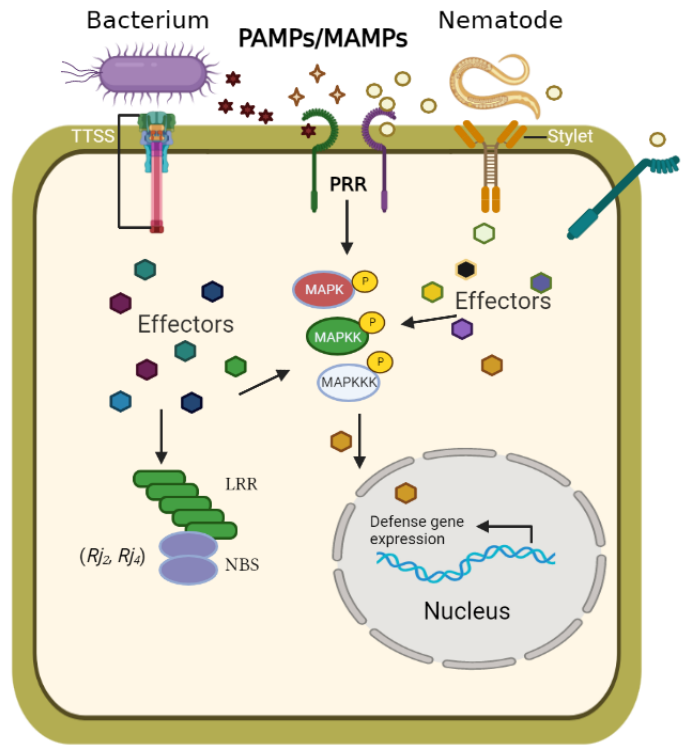
Figure 1. Schematic of soybean immunity response to effectors. Pathogens and rhizobium of all lifestyle classes (color and labeled) express PAMPs (pathogen-associated molecular patterns) and MAMPs (microbe-associated molecular patterns) as they colonize soybean (shapes are color coded to the pathogens and rhizobium). Soybean perceives these via extracellular PRRs and initiates PRR- mediated immunity (PTI). Pathogens and rhizobium deliver effectors to both the soybean cells and cell apoplast to block PAMP/MAMP perception (not shown). These effectors are addressed to specific subcellular locations where they can suppress PTI and facilitate virulence and symbiosis. Intracellular NLR receptors can sense effectors. It is not yet clear whether each of these activation modes proceeds by the same molecular mechanism, nor is it clear how, or where, each result in NLR-dependent effector-triggered immunity (ETI). (Modified from Okazaki and Dangl [5,63]).